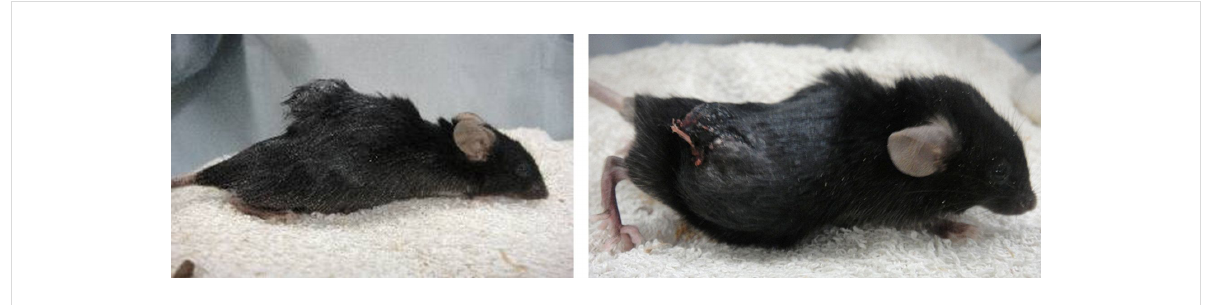
Figure 8: Two mice of both PTX (left) and DDMC/PTX4 (right) groups after 208 hours from I.P. In the mice of DDMC/PTX4 group necrosis was induced by TNF- α . The increase of TNF- α in an individual has been checked by the phoresis results after RT-PCR. Reprinted from